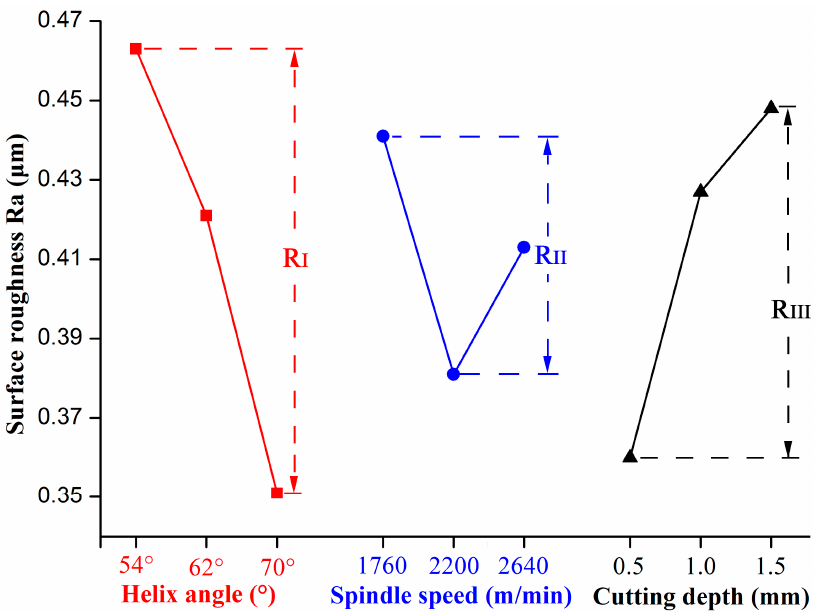
Figure 7. Influence of cutting conditions on surface roughness.